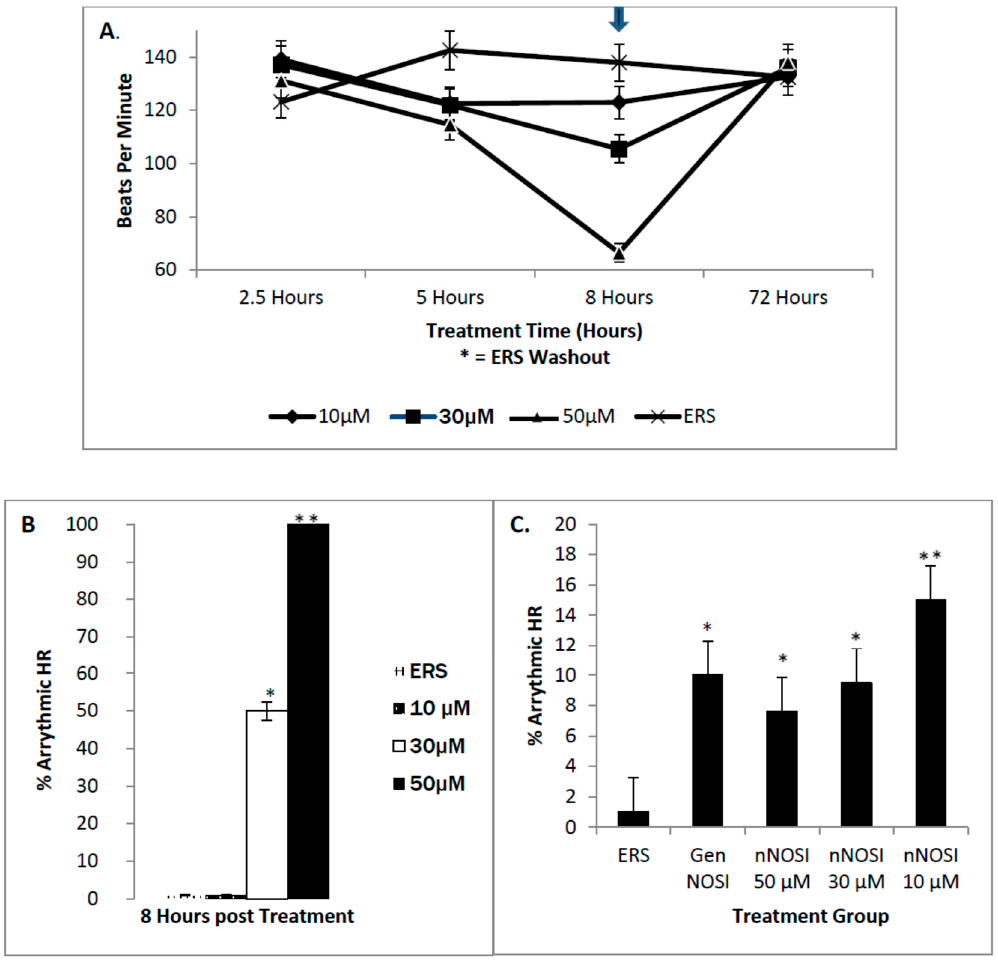
Figure 3. The dose–response effects of nNOSI on zebrafish treated at 2 and 6 dpf and analyzed for heart rate and arrhythmia phenotypes at 4 dpf and 8 h post treatment respectively. ( A ) A depiction of